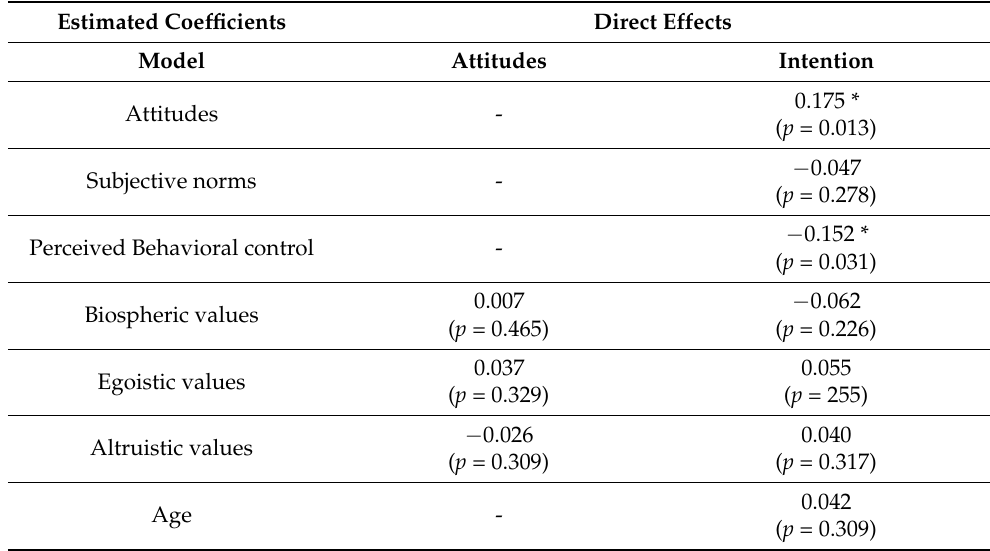
Table 8. Differences for path coefficients by education (middle education versus higher